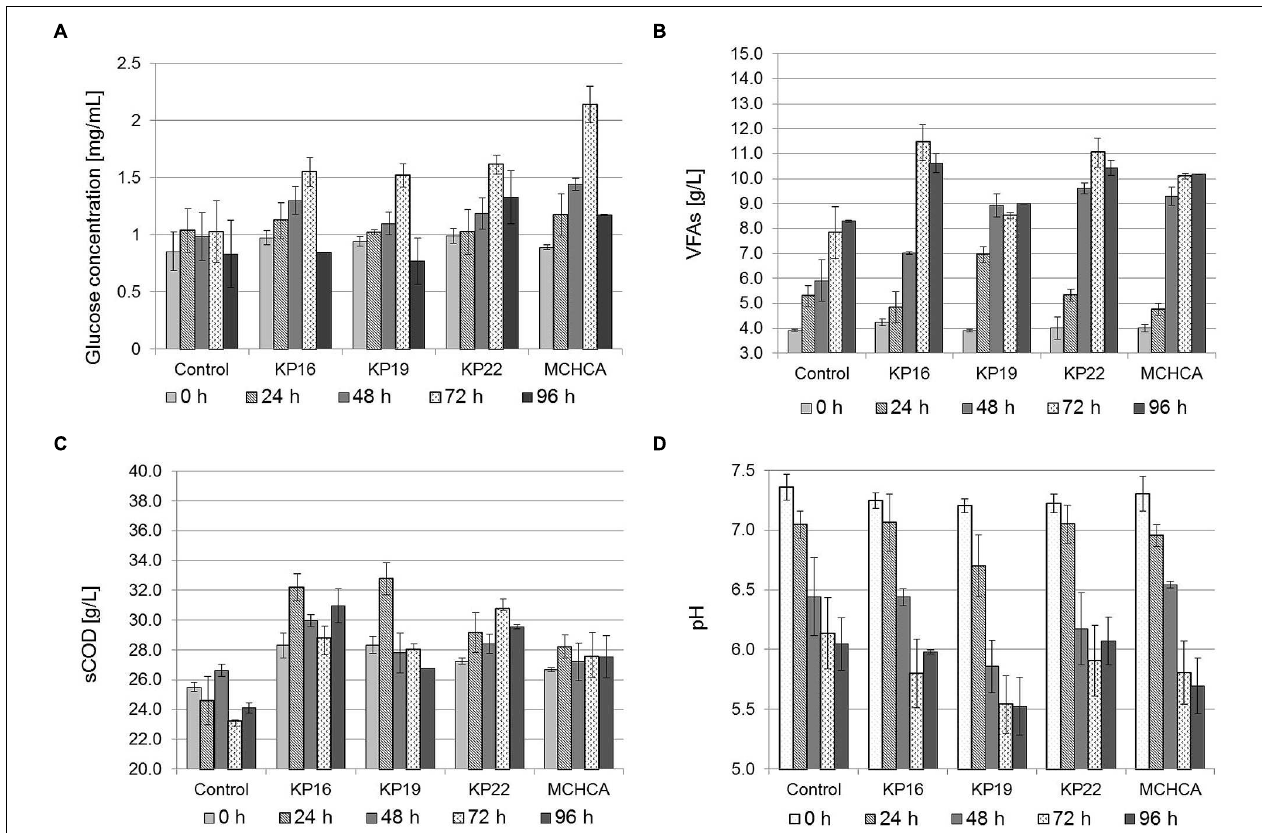
FIGURE 3 | Solubilization of maize silage by cellulolytic bacteria. Analysis of the changes in the concentration of: glucose (A) , VFAs (B) , as well as changes in sCOD (C) and the pH (D) during anaerobic treatment of maize silage (3% DW) by single strains KP16, KP19 KP22 and MCHCA in MSW